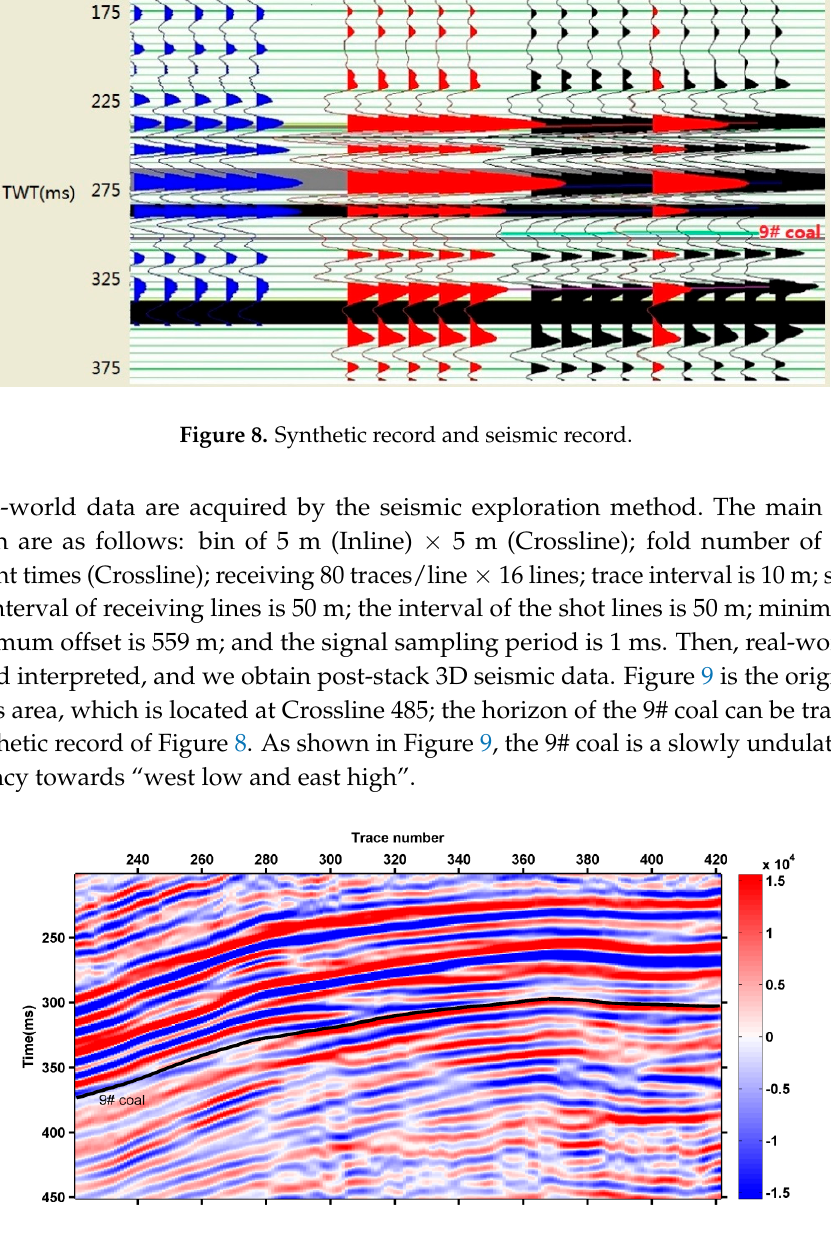
Figure 9. The original seismic data.